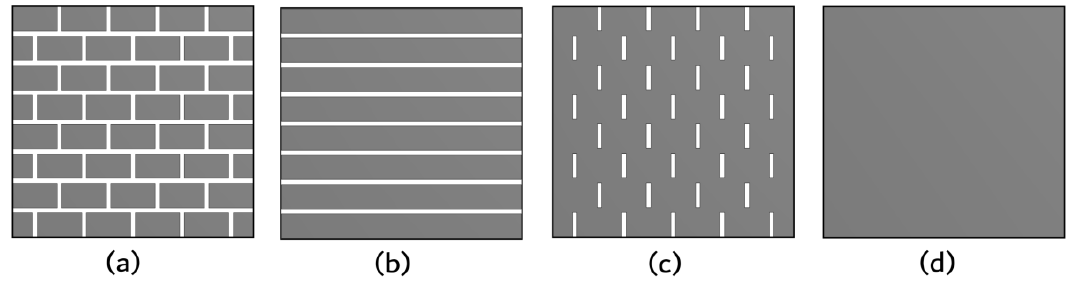
Figure 3. Possible joint patterns of mortarless refractory masonry structure: ( a ) Pattern i, ( b ) pattern ii, ( c ) pattern iii, and ( d ) pattern iv.